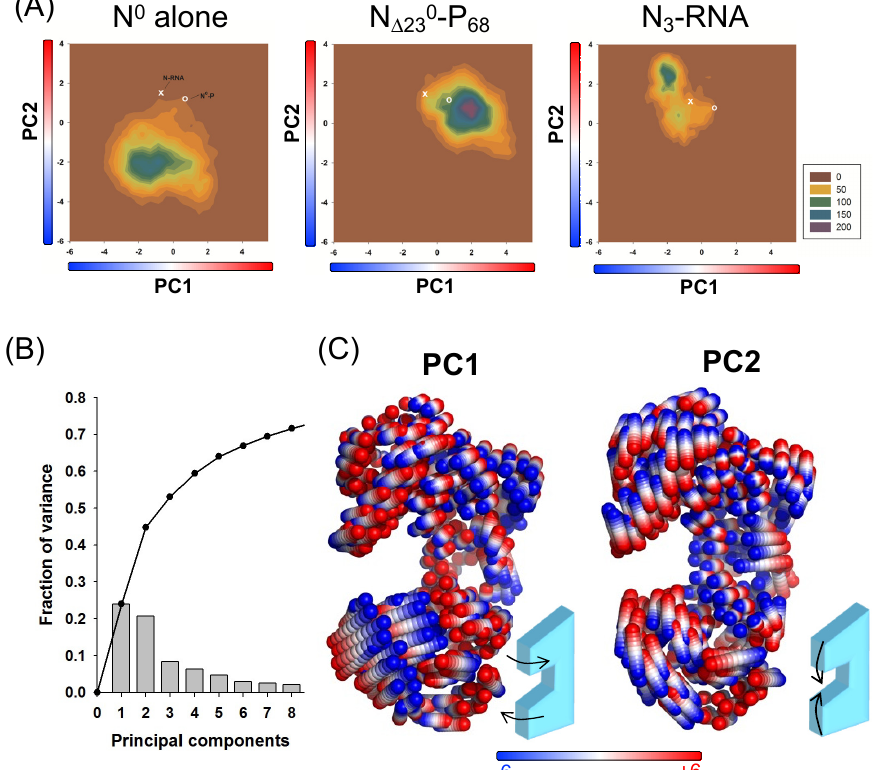
Figure 6. Molecular dynamic simulations. ( A ) Principal component analysis (PCA); 2D projections of the first two principal components (PCs) calculated for the N protein from MD simulations run with N 0 alone (left panel), N Δ23 − P 68 (middle panel) and N 3 − RNA (right panel). The data are shown as a 2D histogram with the density distribution color scheme indicated on the right. The value calculated from the crystal structures of the N 11 − RNA complex and N Δ23 − P 68 complex are shown for reference on each graph as a white cross and a white circle, respectively. ( B ) Fraction of the variance captured by each PC (histogram) and cumulative contributions of the first eight PCs. ( C ) Collective motions of N captured by PC1 and PC2. The motions are illustrated as linear interpolations between the extreme projections of the structures onto the PCs. Each cylinder thus describes the path of a C α atom between its extreme positions (on a red–white–blue color scale).